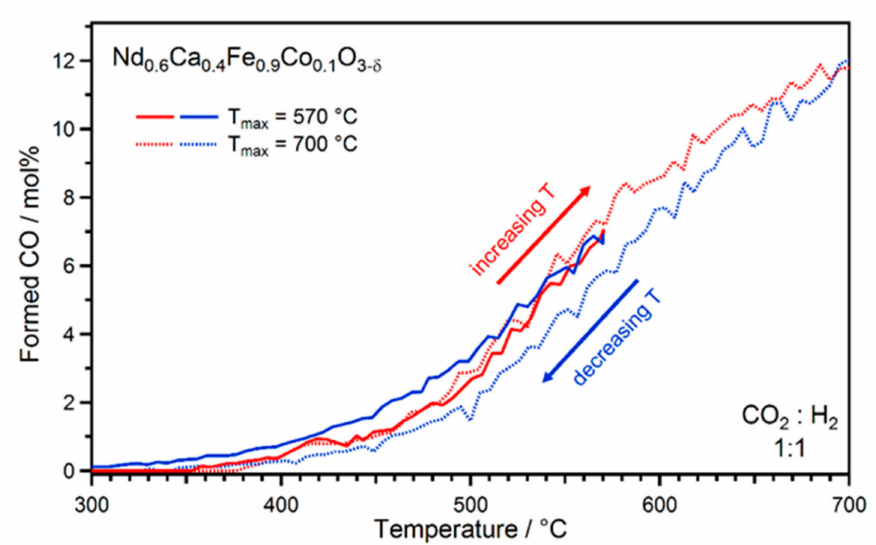
Figure 4. CO formation during two different double ramp rWGS experiments on Nd 0.6 Ca 0.4 Fe 0.9 Co 0.1 O 3- δ . Two different hysteresis loops could be observed. When